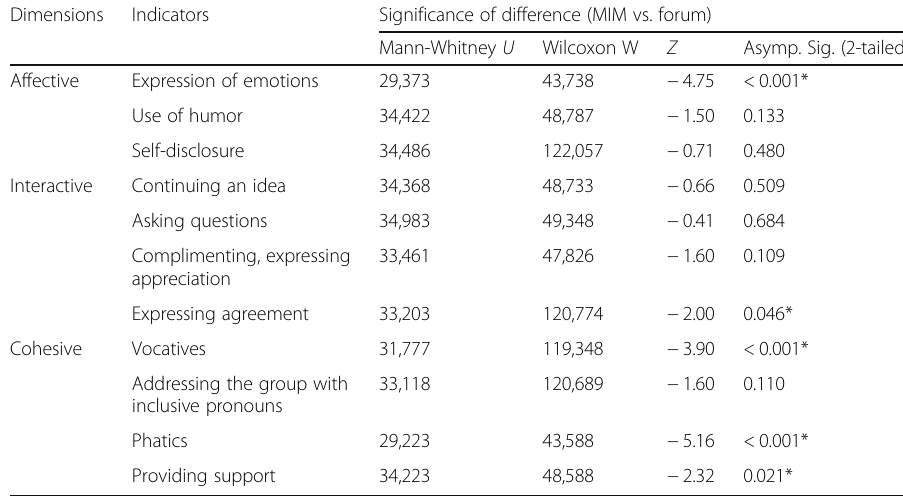
Table 3 Comparison of social presence by indicators